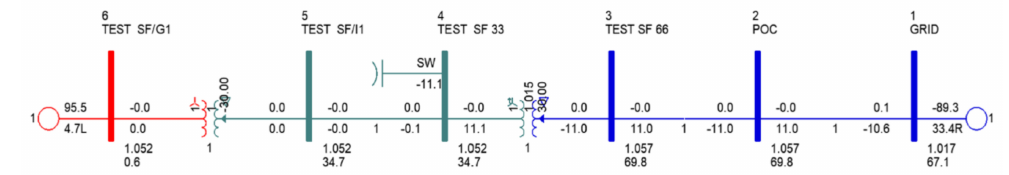
Figure 1. PSSE model of a Practical 100MW AC Solar Farm in South Australia.